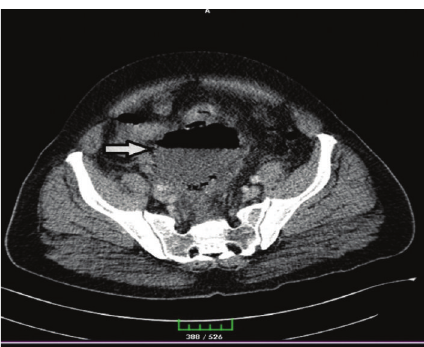
Figure 1: CT image showing 98×95 mm abscess with air-fluid levels at the entrance to the pelvic cavity.